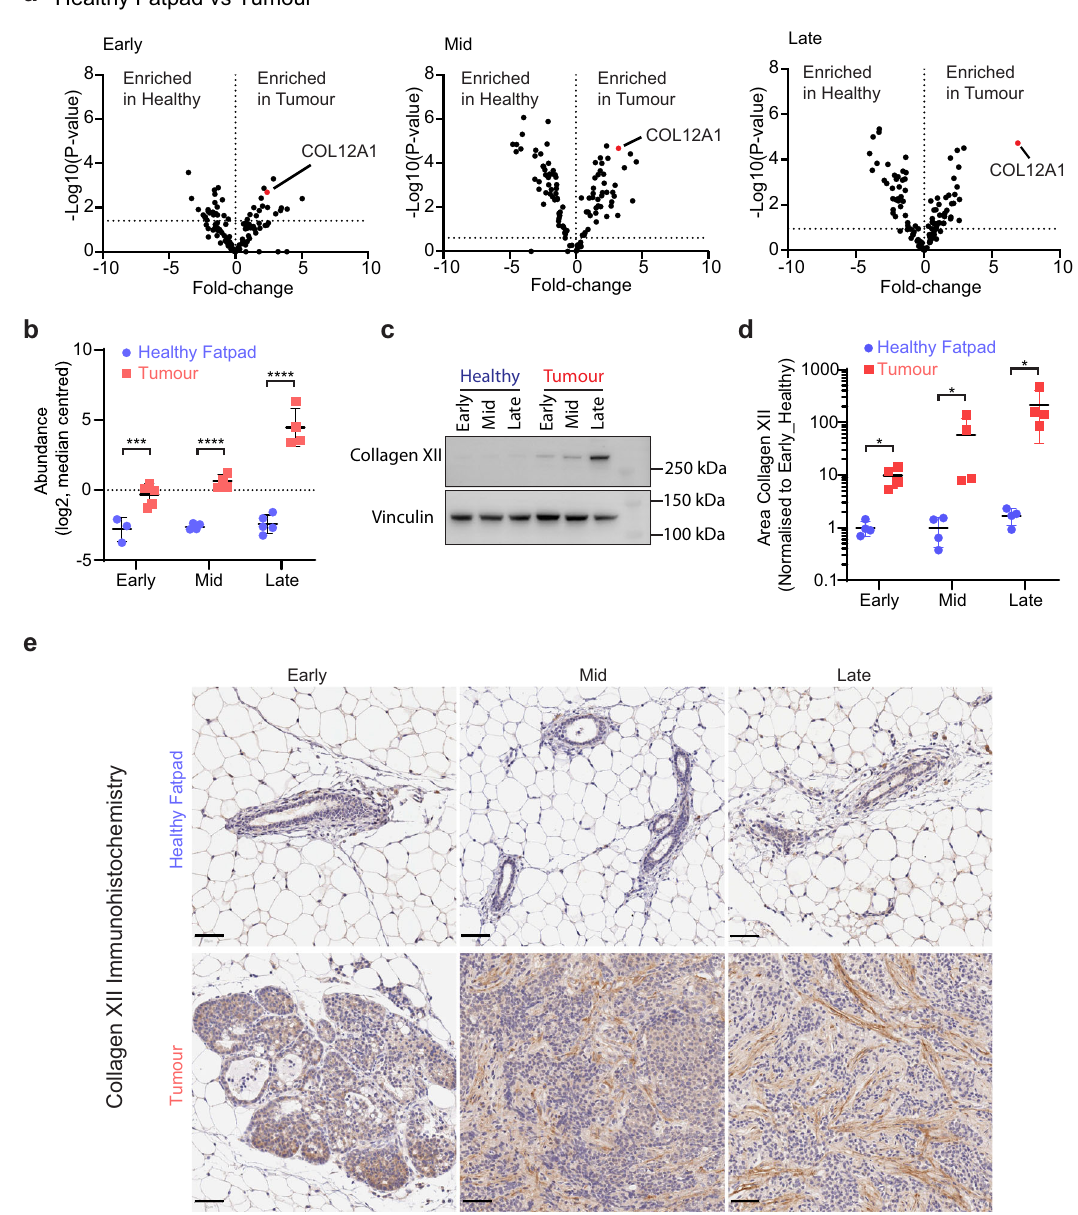
Fig.2|CollagenXIIisupregulatedinbreasttumoursasthediseaseprogresses. a Volcano plot of differentially abundant matrisome proteins from LC-MS/MS in matched healthy fatpad or mammary tumour at the early, mid or late stages high- lighting collagen XII elevation in mammary tumours at each stage. Multi-sample t testwithFDR correction. Dataderived from n =4 mice for the tumour group at mid stageand n =5miceforallothergroups. b CollagenXIIproteinabundanceintumour and matched healthy fatpad tissue, quanti fi ed by LC-MS/MS (log 2 transformed, mediancentred, collagenXIIwas detected in n =25of 30samples correspondingto tissue samples from n =3 mice in the healthy early stage group, n =4 mice in the healthy mid, tumour mid and tumour late stage groups and n =5 mice from the